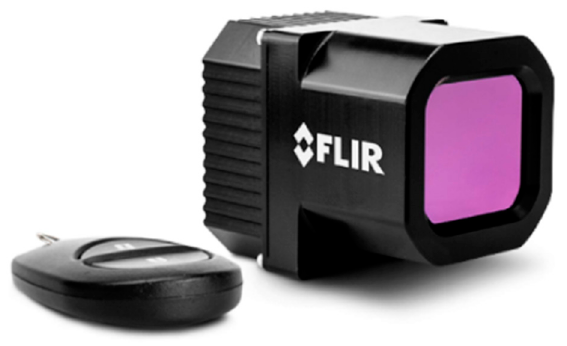
Figure 10. Thermal Vision FLIR ADK by FLIR Systems [170].